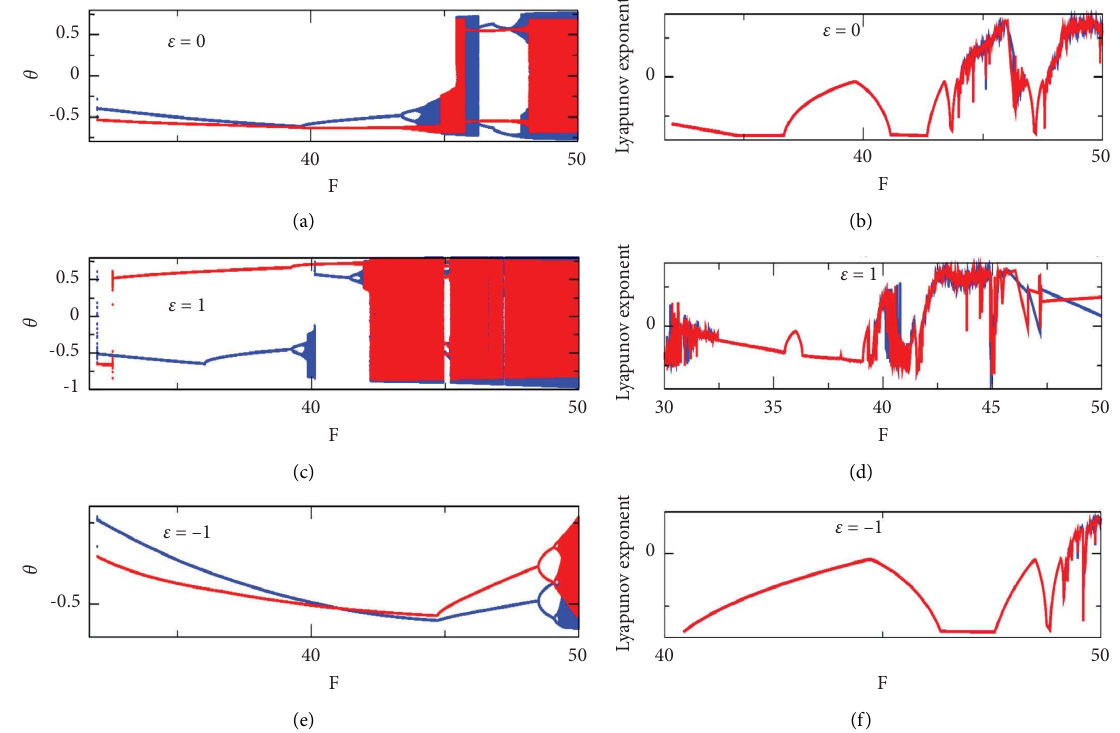
Figure 11: Bifurcation diagrams and its corresponding Lyapunov exponents for ϵ � 0 ; ± 1 plotted by sweeping the normalized amplitude F in the increasing direction (blue) and towards the opposite direction (red) and for the values of the parameters: α � 10 ; β � 1 ; Ω � 2 ; C